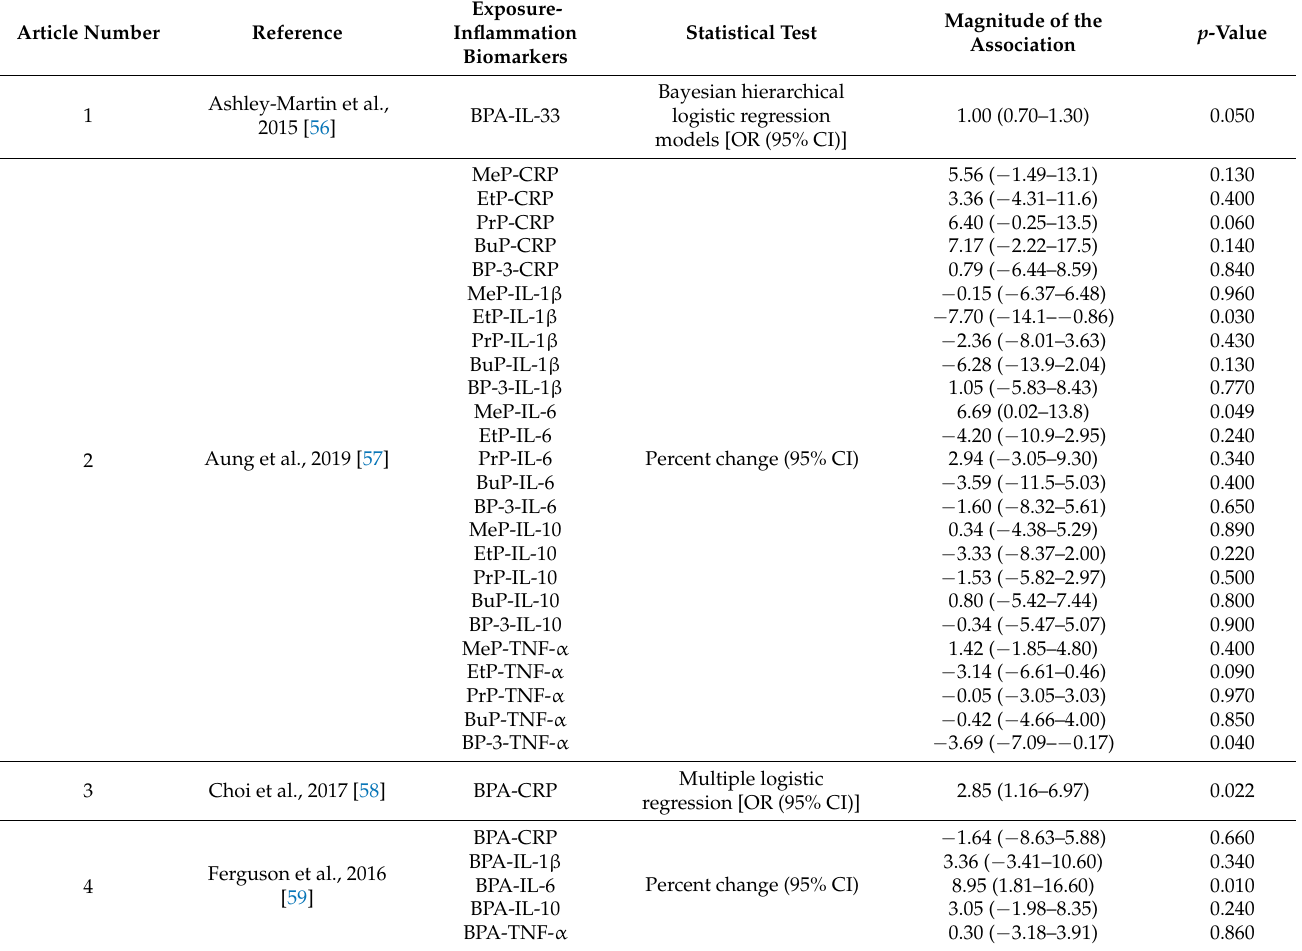
Table 4. Association between concentrations of bisphenols, parabens, and benzophenones and levels of inflammation